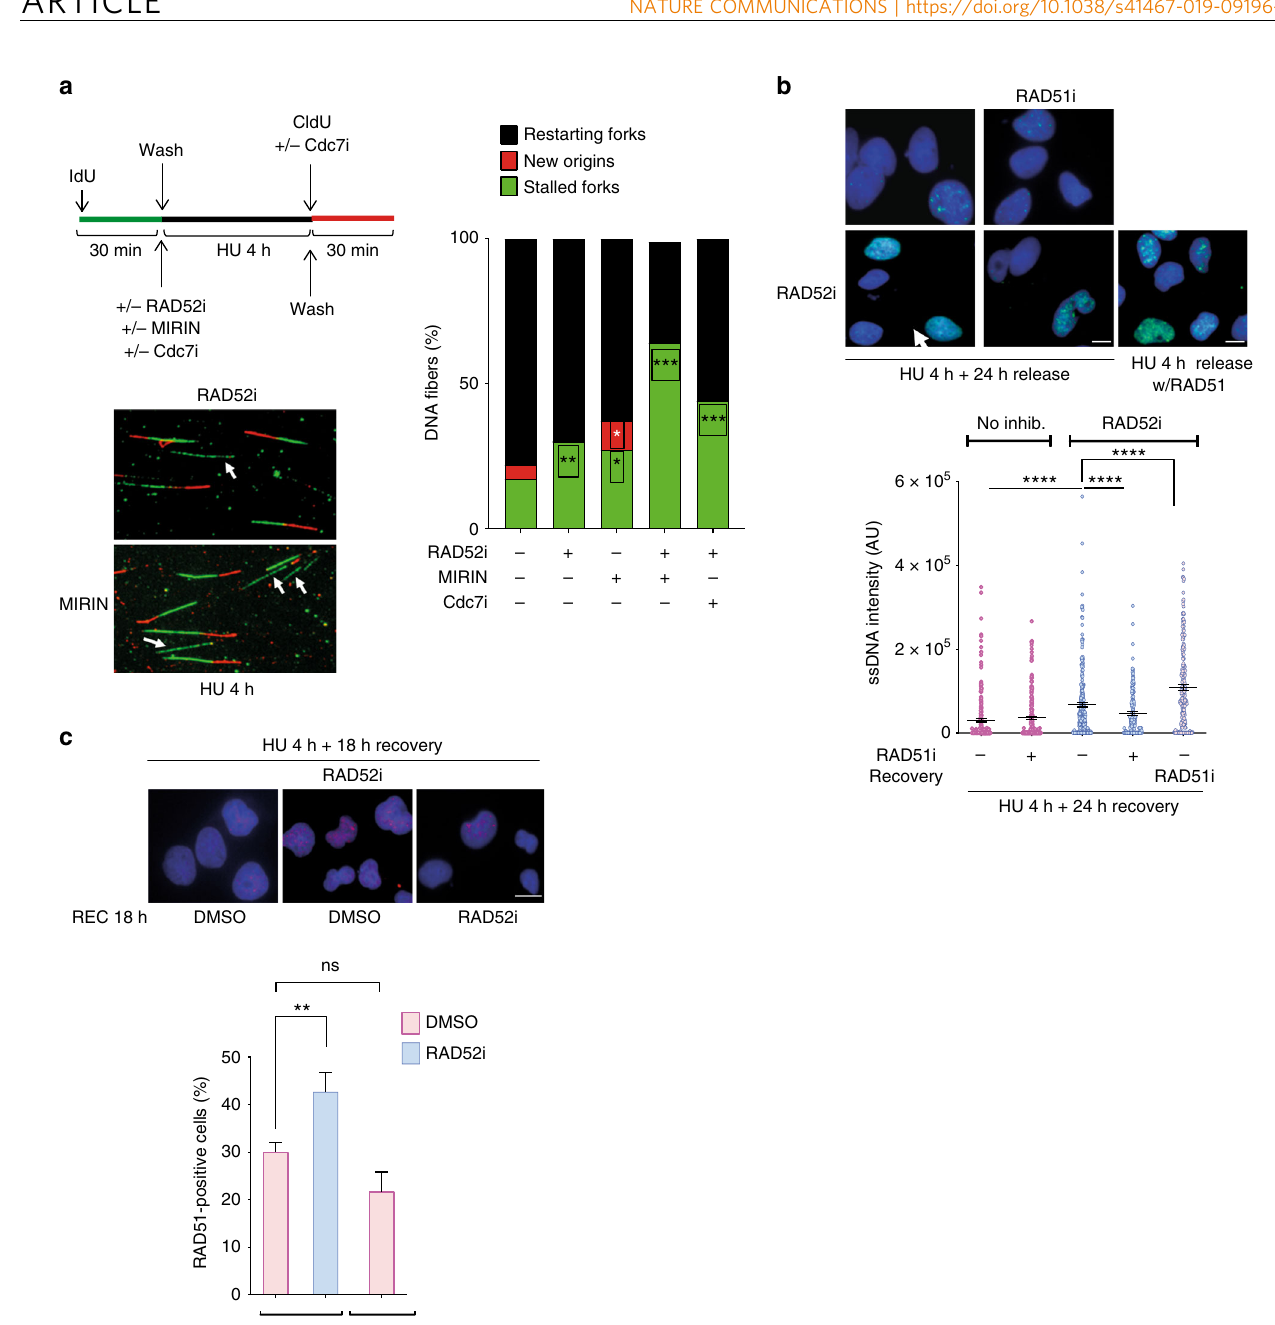
Fig. 7 Loss of RAD52 leads to persistence of unreplicated DNA. a Analysis of replication fork restart using DNA fi bre assay. Cells were treated as indicated in the scheme on the top. The graph shown the percentage of each event. Representative images of DNA fi bres fi elds are presented. Arrows denote stalled forks. (* P < 0.05; ** P < 0.01; *** P < 0.001; ANOVA test; N = 140). b Analysis of the persistence of parental ssDNA (template gaps) during recovery from replication arrest. Cells were treated as indicated and analysed by the native iododeoxyuridine (IdU) assay. The graph shows the intensity of ssDNA staining in at least 100 nuclei from two independent experiments. Values are presented as means ± SE (**** P < 0.0001; Mann – Whitney test; N = 141). Representative images are shown. c Analysis of RAD51 nuclear foci. Cells were treated with 2 mM hydroxyurea (HU), in the presence or not of the RAD52i, for 4 h and recovered as indicated, without or with RAD52i. The graph shows the percentage of nuclei with RAD51 foci. Data are presented as mean ± SE from three independent experiments. (ns, not signi fi cant; ** P < 0.01; ANOVA test; N = 145). Representative images are shown. Scale bar represents 5 µ m. Source data are provided as a Source Data fi